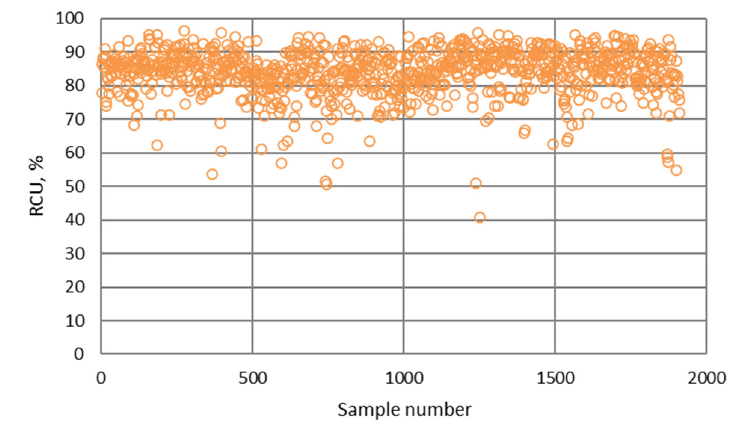
Figure A16. PMM model—training dataset for RCU output variable.